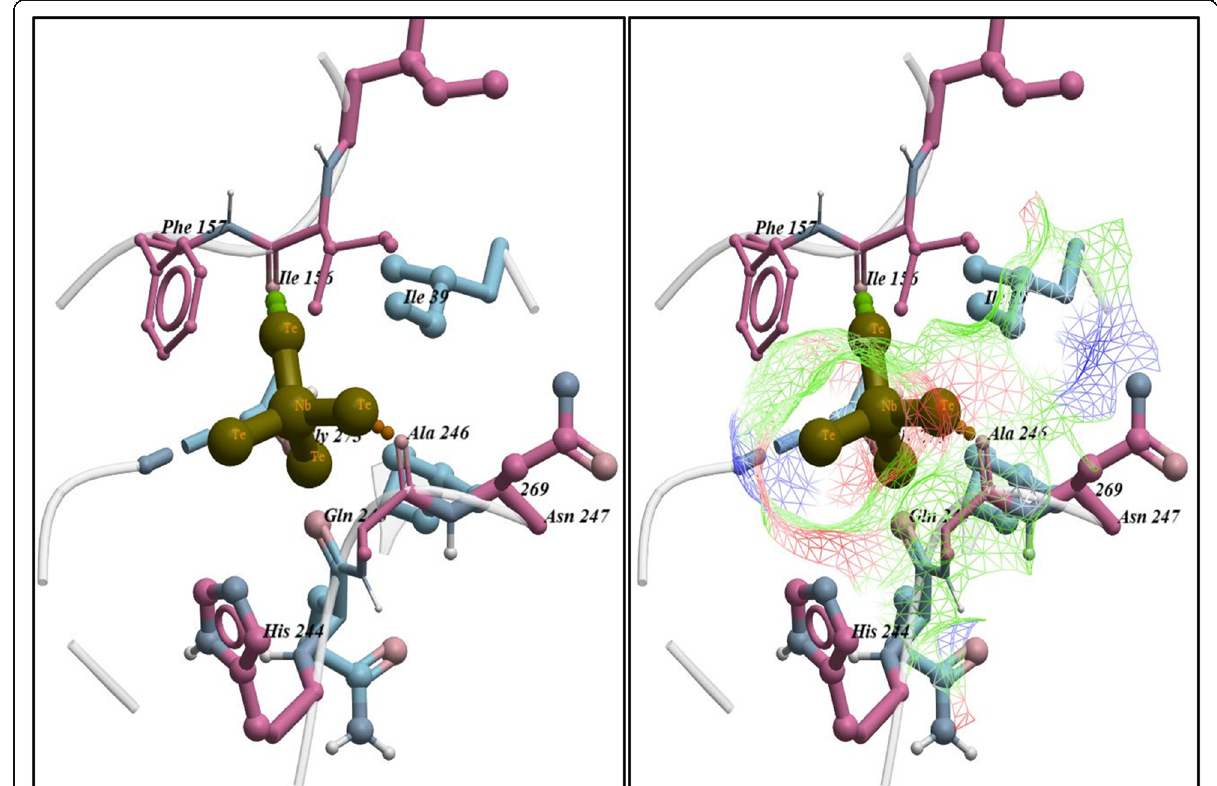
Fig. 11 Binding interaction pattern of NbTe 4 NPs with active site residues of beta-ketoacyl-acyl carrier protein synthase III (FabH) from E.